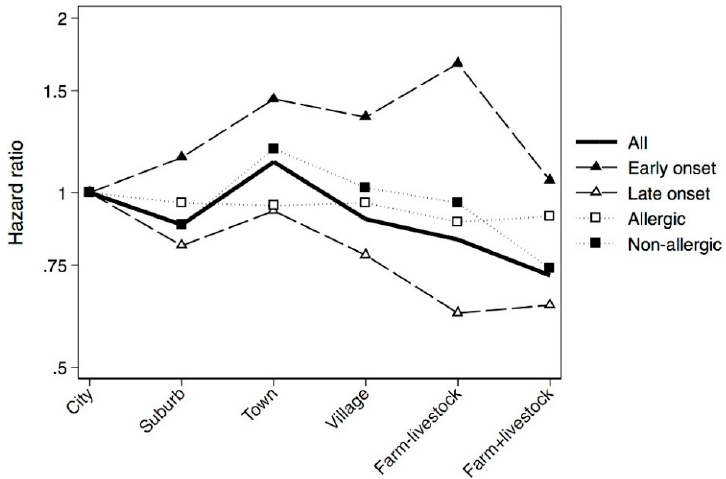
Figure 2. Cox regression analyses on asthma phenotypes presented as HR adjusted for age, sex, centre, parental asthma, smoking, body silhouette at 8 years of age and parental smoking in childhood.